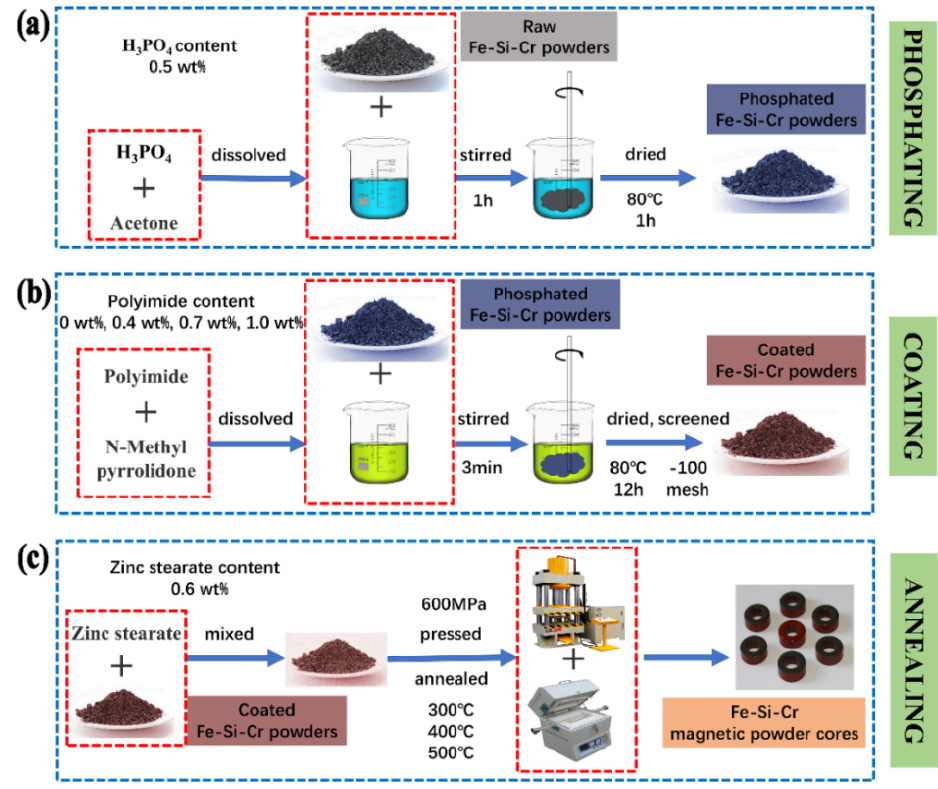
Figure 1. The preparation process of Fe-Si-Cr@PI core–shell structure coating and magnetic powder cores: ( a ) phosphating, ( b ) coating, and ( c ) annealing.